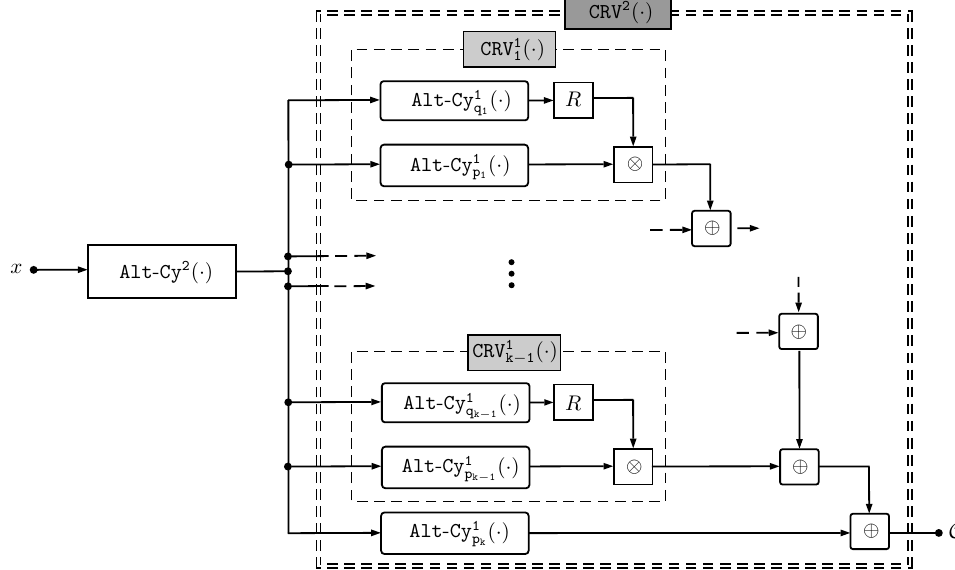
Figure 6: Gadget Alt - CRV ( · ) : circuit of the alternate CRV